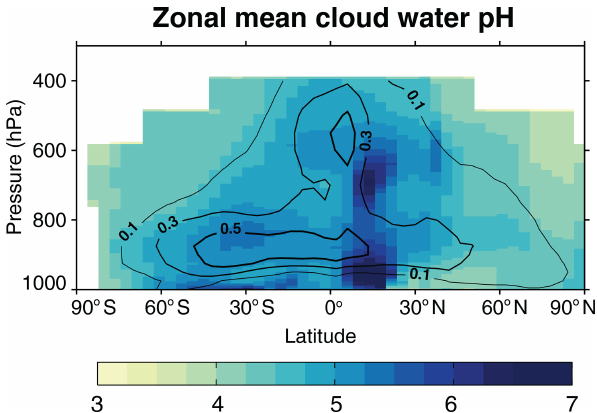
Figure 4. Zonal mean cloud water pH simulated by GEOS-Chem. Values are annual volume-weighted averages for the year 2013. The contour lines show the annual mean MERRA-2 cloud liquid water content in grams per cubic meter (gm − 3 ) for the cloudy fraction of grid cells where a liquid cloud is present. White color denotes areas where the cloud liquid water content is below 0.01gm − 3 .